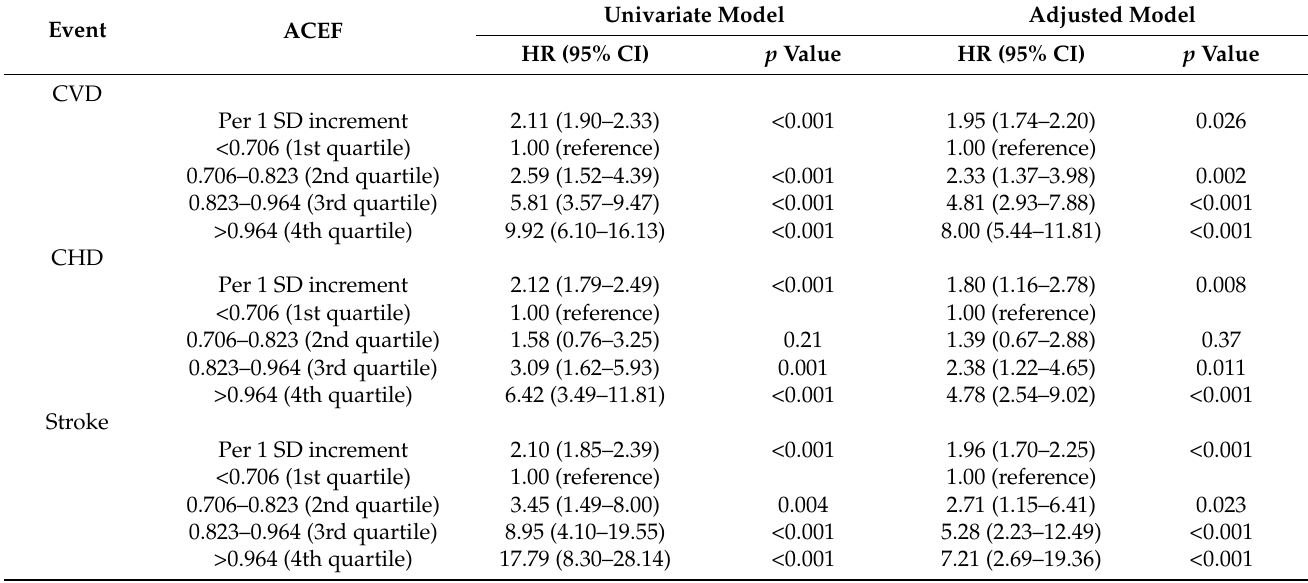
Table 2. Univariate and multivariate Cox proportional hazards regression analysis of CVD events.